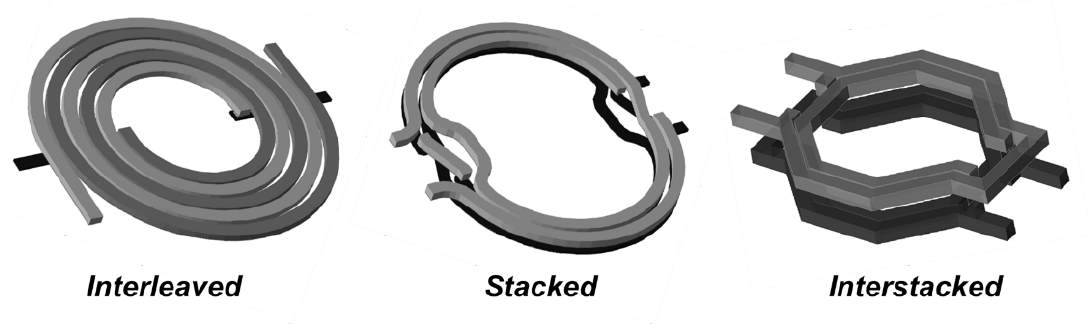
Figure 2. Simplified representation of integrated transformer configurations with increasing magnetic coupling coefficient, k.